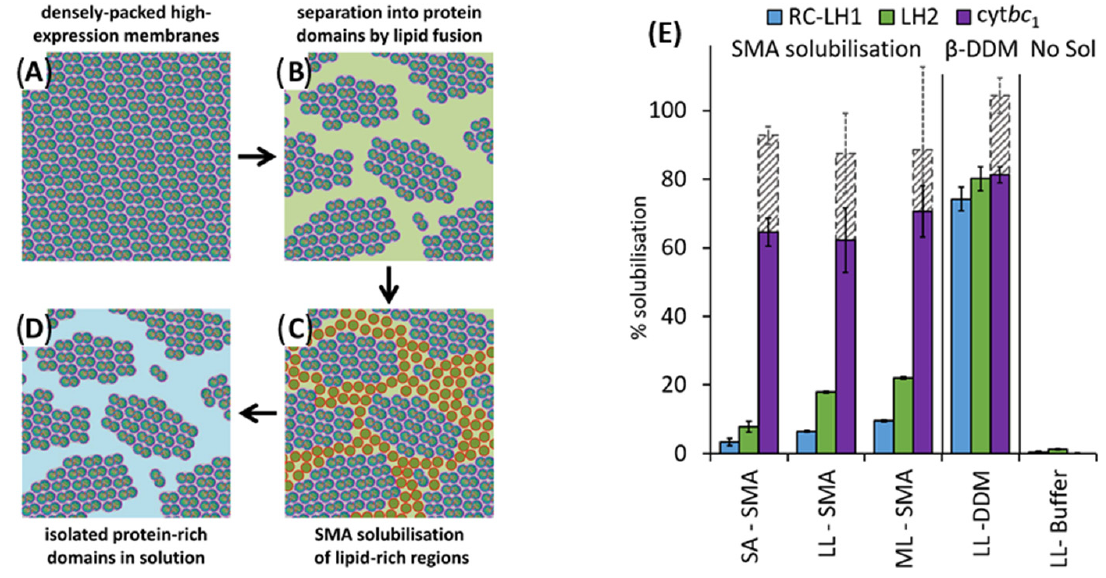
Figure 4. Model for the formation of membrane patches on SMA treatment. ( A ) SMA-resistant high-expression RC-LH1-X membranes have a low lipid:protein ratio and limited regions of the lipid bilayer. ( B ) Fusion with lipids or SMA-amenable bilayer-rich membranes introduces lipid-rich regions (pale green) between domains of closely packed RC-LH1-X complexes. ( C ) The addition of SMA causes solubilization of bilayer-rich regions as SMA-lipid nanodiscs (red/olive green). ( D ) This treatment liberates protein-rich membrane fragments that are sufficiently small to stay in solution (blue) during clearing ultracentrifugation spins and pass through the matrices of chromatography columns. ( E ) Extraction efficiencies of RC-LH1-PufX (blue), LH2 (green), and the cyt bc 1 complex (magenta) in membranes prepared from cells grown under semi-aerobic (SA) or low light (LL) and medium light (ML) photosynthetic conditions. The left panel shows solubilization in 2.5% w / v SMA polymer, the center panel shows low light membranes solubilized in 3% w / v β -DDM, and the right panel shows results where no solubilizing agents were added. Solid bars show values obtained by spectroscopy, and hatched bars show values for cyt c 1 by heme staining. Error bars indicate the standard error of the mean for three replicates. The inefficient solubilization was due to the poly-